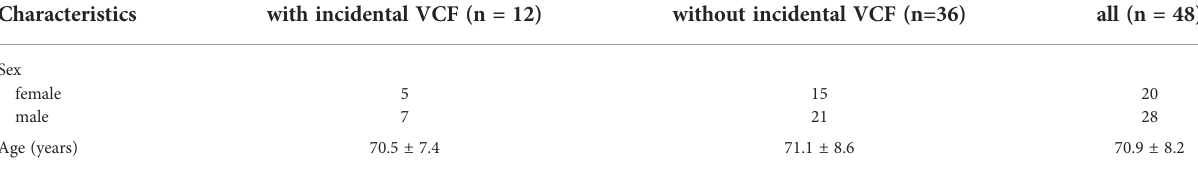
TABLE 1 Patient characteristics.